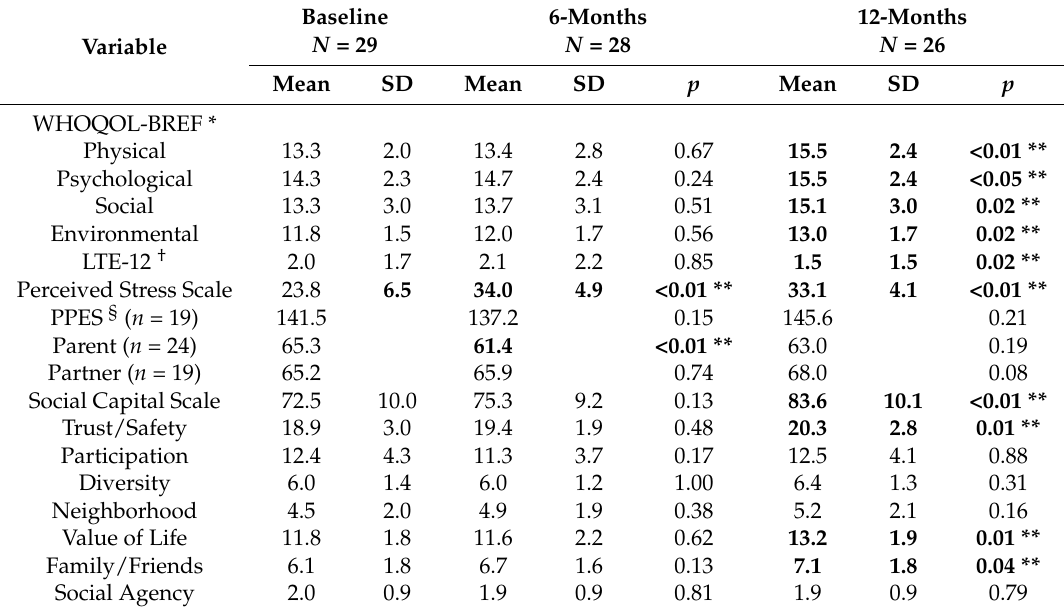
Table 3. The mental health metrics at enrollment and at six and twelve